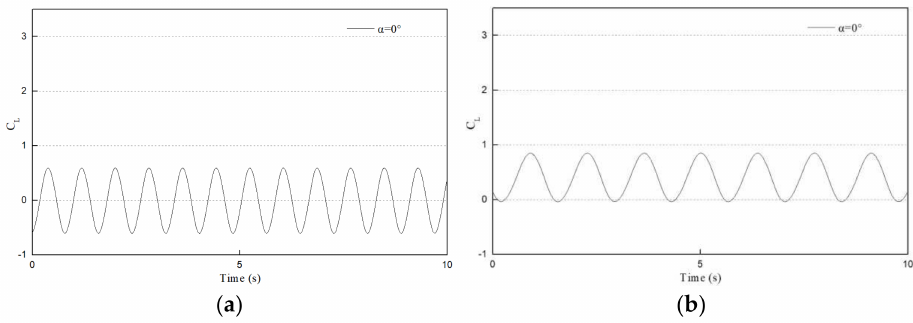
Figure 24. Distribution diagrams of C L flow around a circular-ended pier: ( a ) α = 0 ◦ ; ( b ) α = 15 ◦